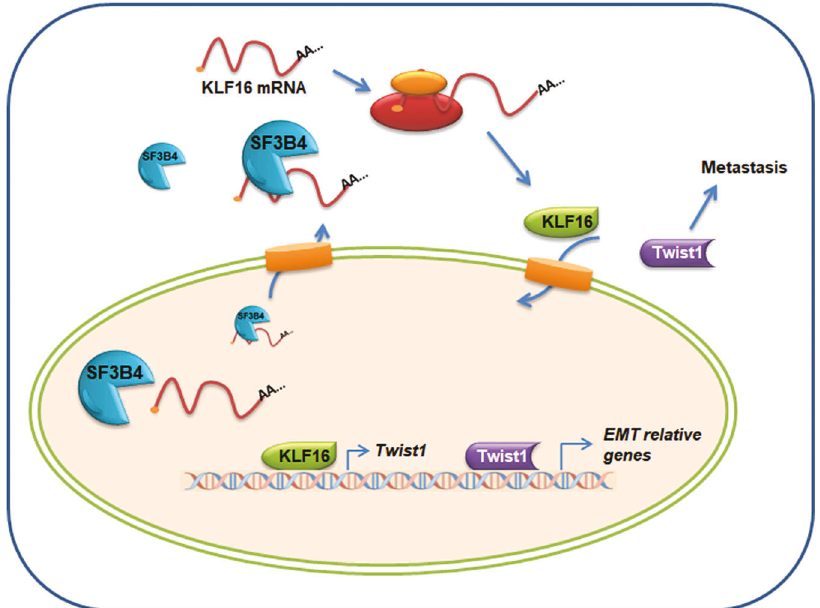
Fig. 9 Proposed model for SF3B4-KLF16-Twist1 regulation of pRCC